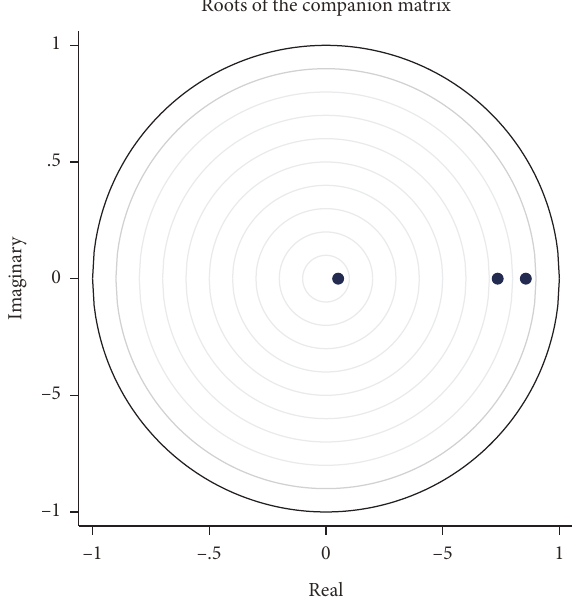
Figure 2: Stability